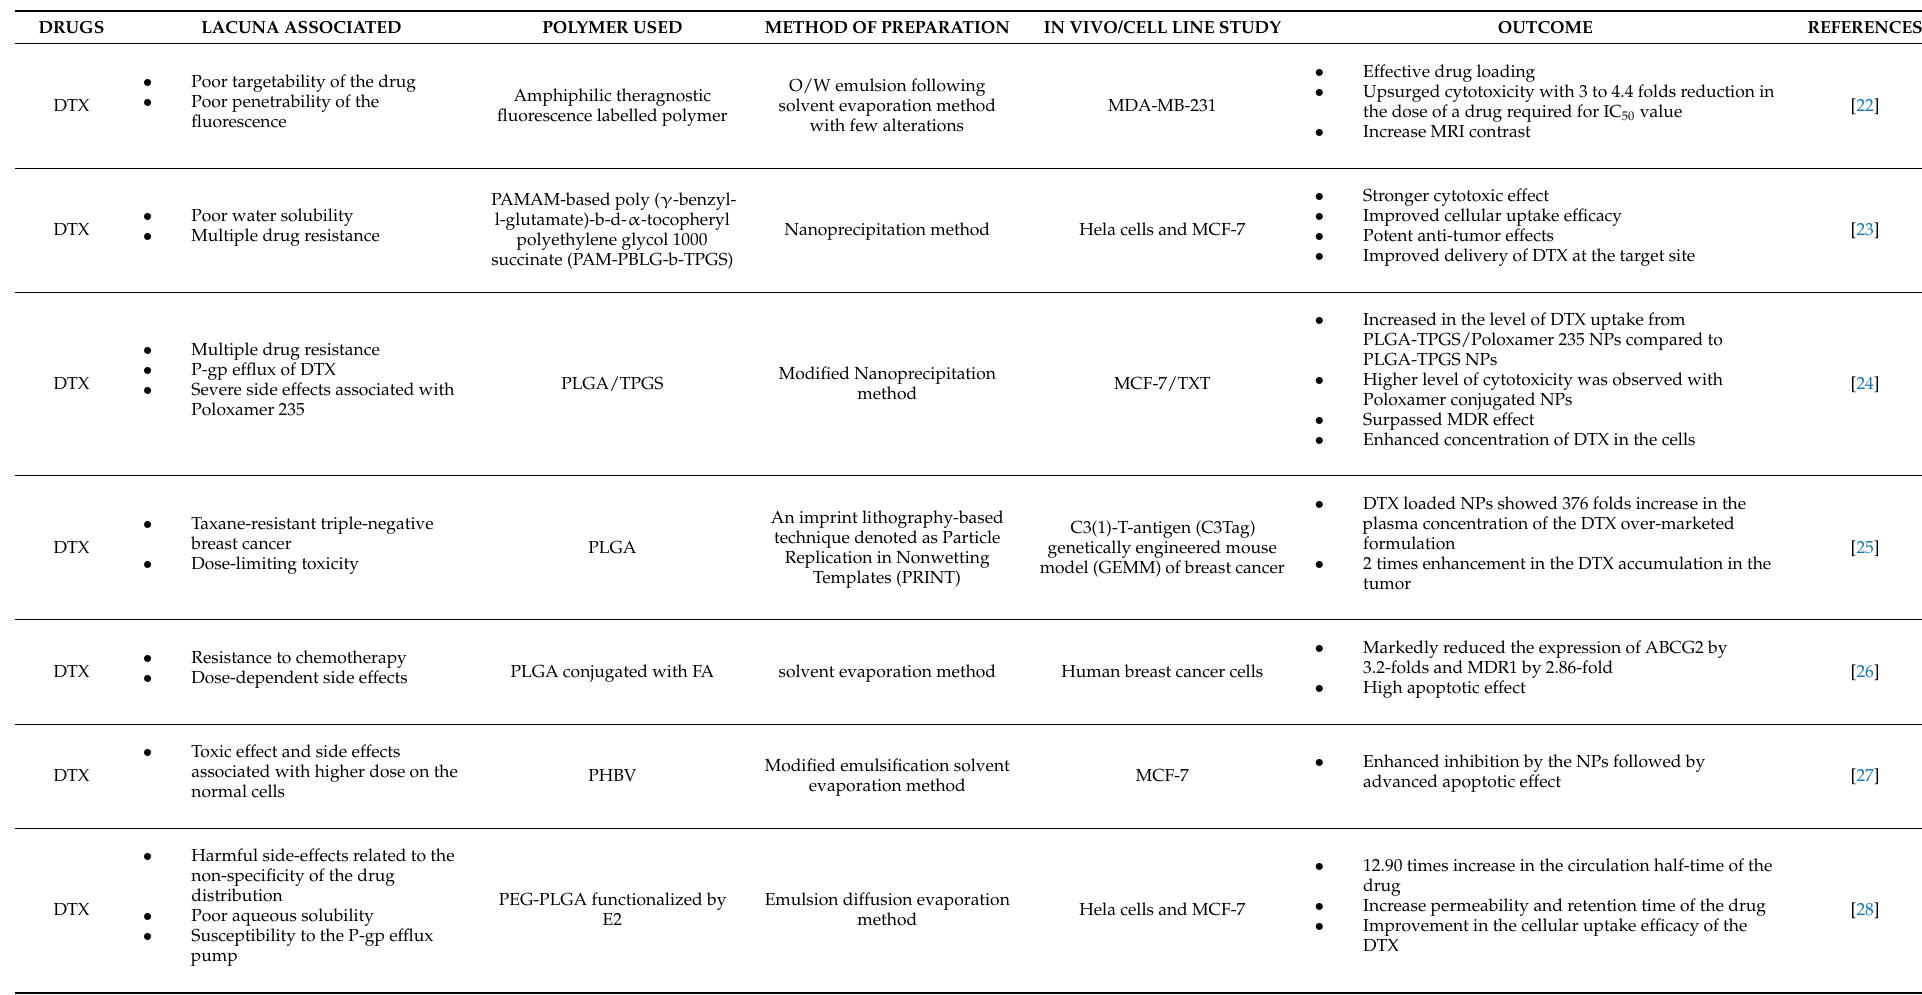
Table 2. Docetaxel and their combination polymeric nanoparticles for breast cancer